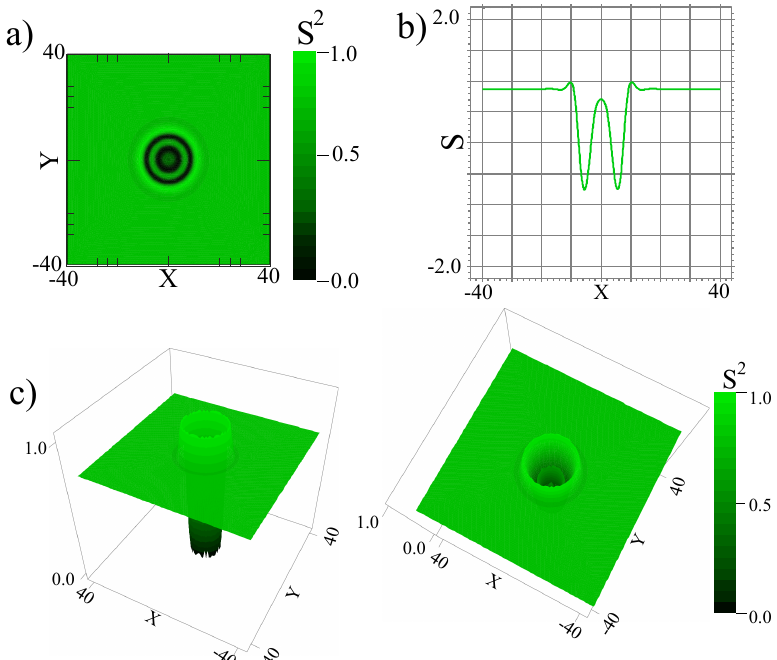
Figure 6. Numerical stationary ring pattern in a dye-doped nematic liquid crystal using the effective model in Equation (9) for ˜ A = − 0.5, ˜ B = 0.3, ν = 1.05, b = 0.1, I 0 = 1.45, and w = 4. ( a ) Contour plot of the squared order parameter S . ( b ) Profile of the cut of the order parameter S in the diameter of the ring pattern. ( c ) Surface plot of the squared order parameter S .